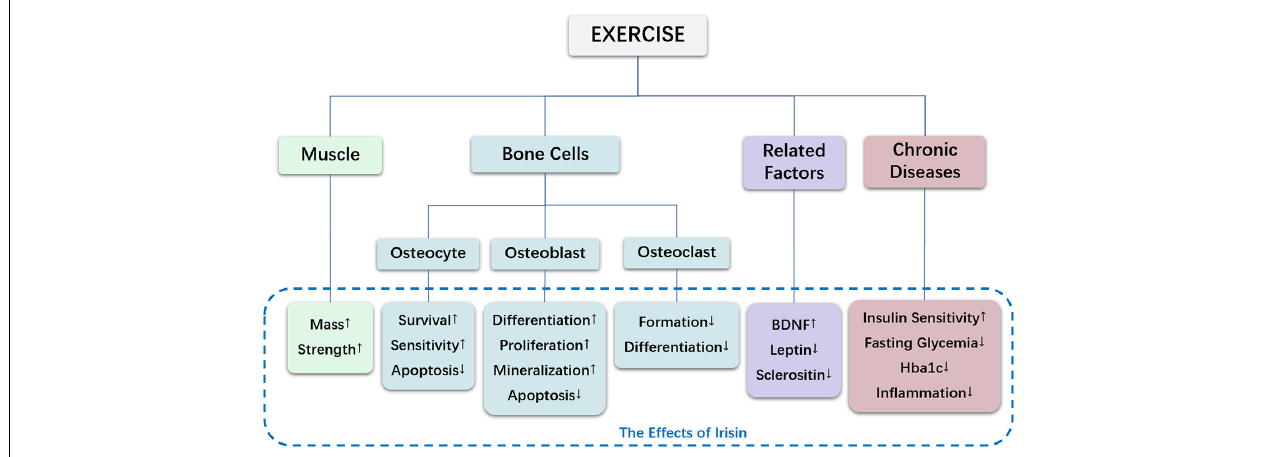
FIGURE 1 | The effects of irisin in exercise-mediated bone metabolism.